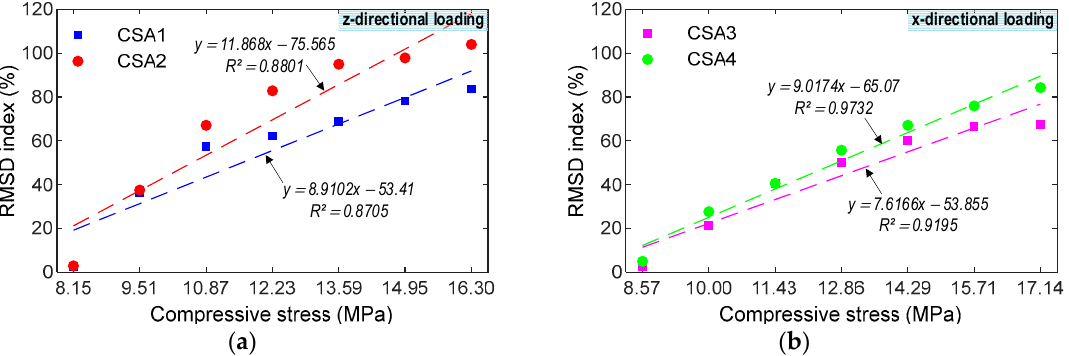
Figure 18. Experimental correlation estimation between RMSD index and compressive stress. ( a ) z- directional loading. ( b ) x-directional loading.